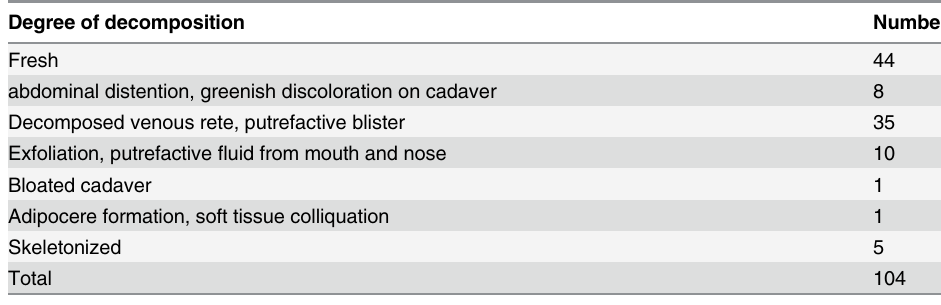
Table 4. Degree of decomposition.